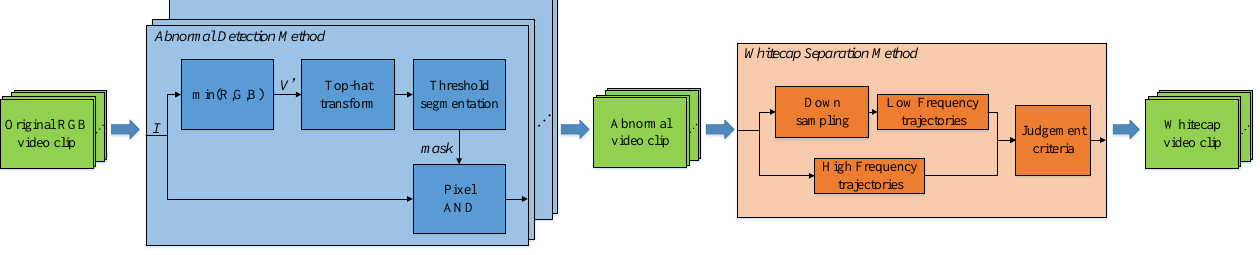
Figure 3. Flowchart of the proposed